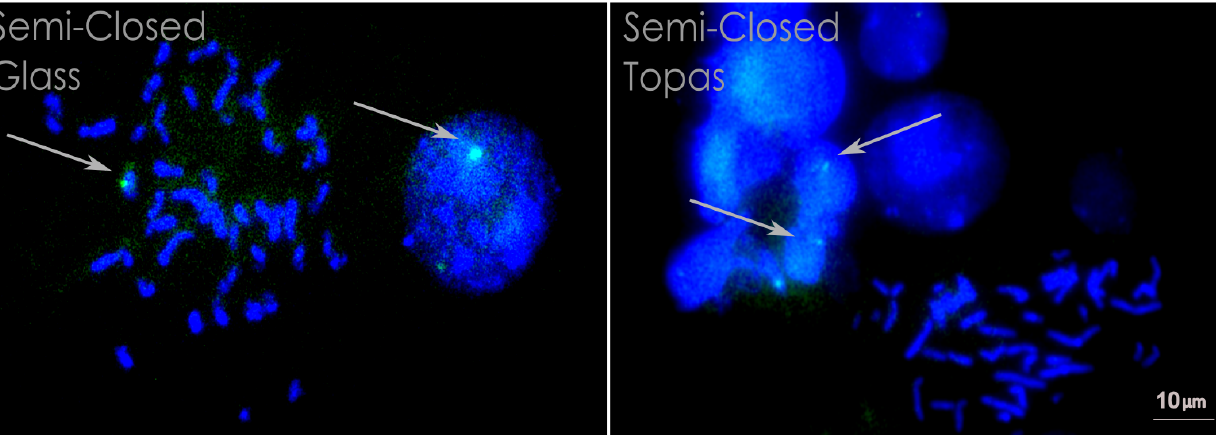
Figure 5. FISH validation of spreads usability. The metaphase signals of X centromeric probe can be seen on spreads prepared in a glass semi-closed device. For the semi-closed Topas (cid:114) device only interphase signals were obtained. The arrows point at the Fluorescence in situ hybridization (FISH)